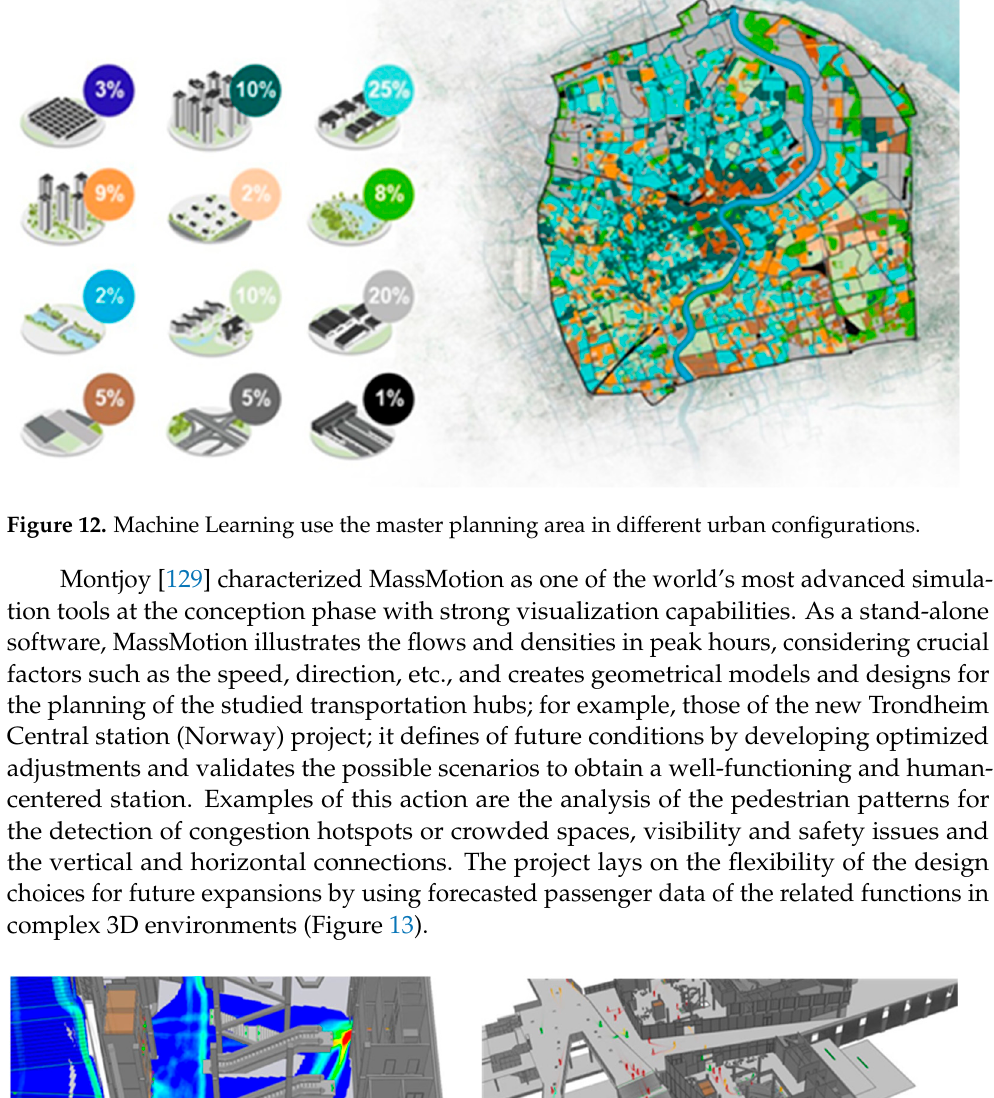
Figure 12. Machine Learning use the master planning area in different urban configurations.